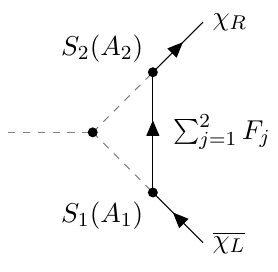
Figure 2 . Leading order diagrams for the decay h → χ L χ R in the mass basis. See the main text for more